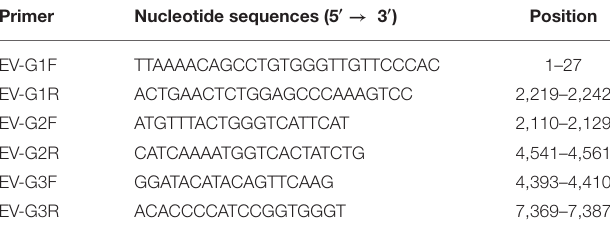
TABLE 1 | The primers used for complete genome amplification of